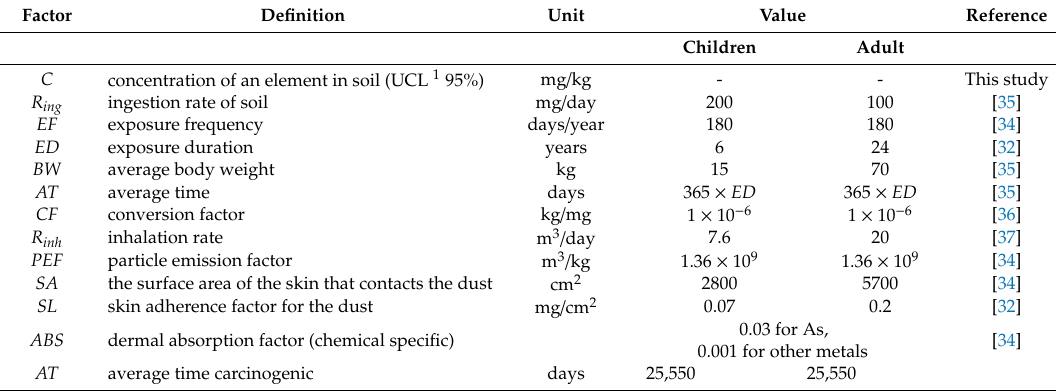
Table 3. Exposure factors for dose models that were used for this study.